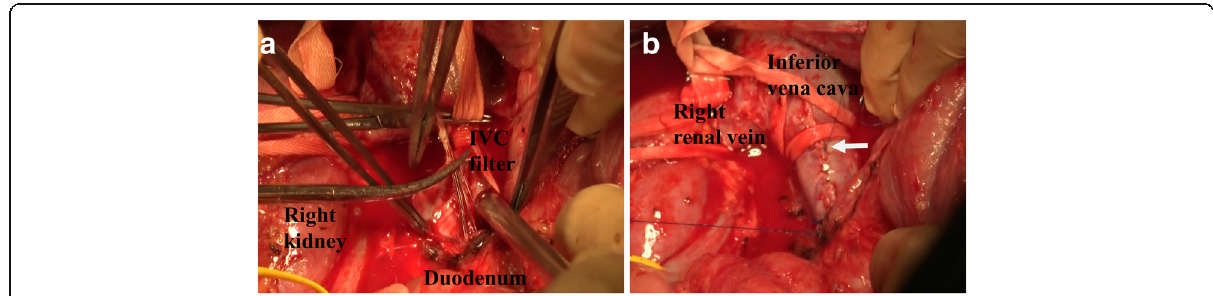
Fig. 4 After clamping the IVC cranial and caudal to the duodenum, IVC filter was retrieved from 5 cm vertical incision of IVC cranial to the duodenum ( a ). IVC incision was closed by continuous suture using 5-0 Prolene (arrow, b )